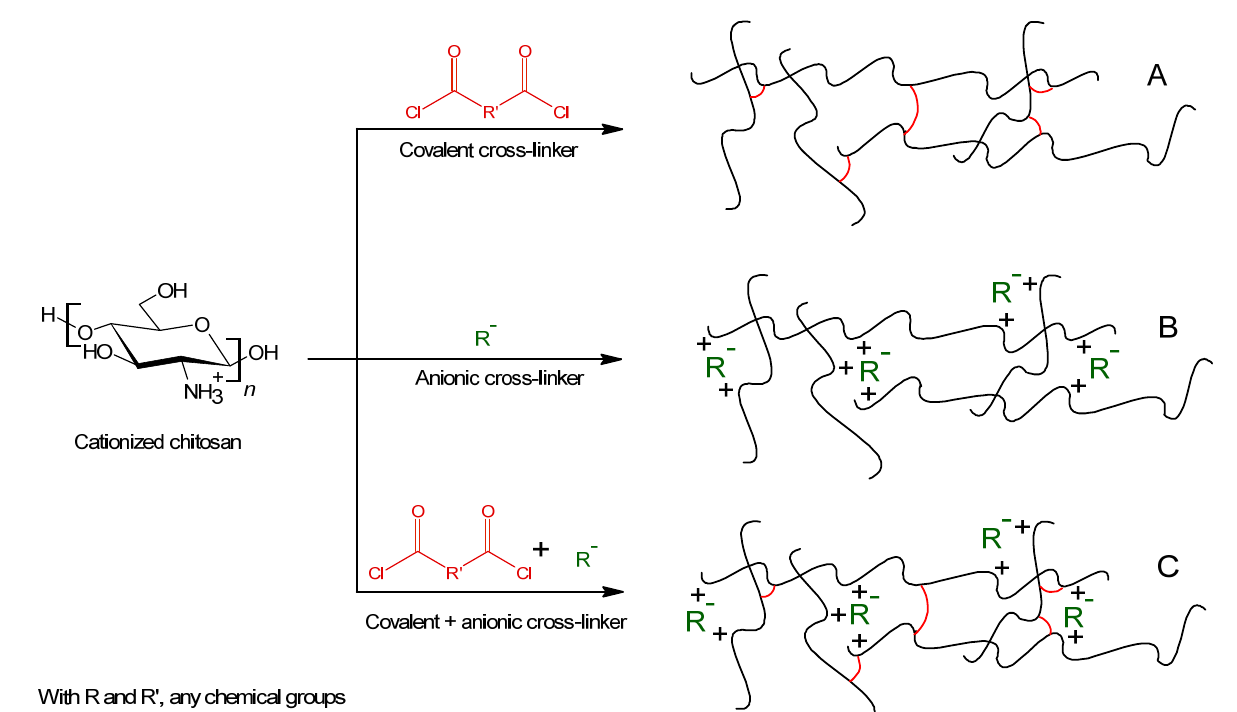
Figure 6. Schematic representation of chitosan covalent cross-linking ( A ), ionic cross-linking ( B ) and co-cross-linking ( C ) .